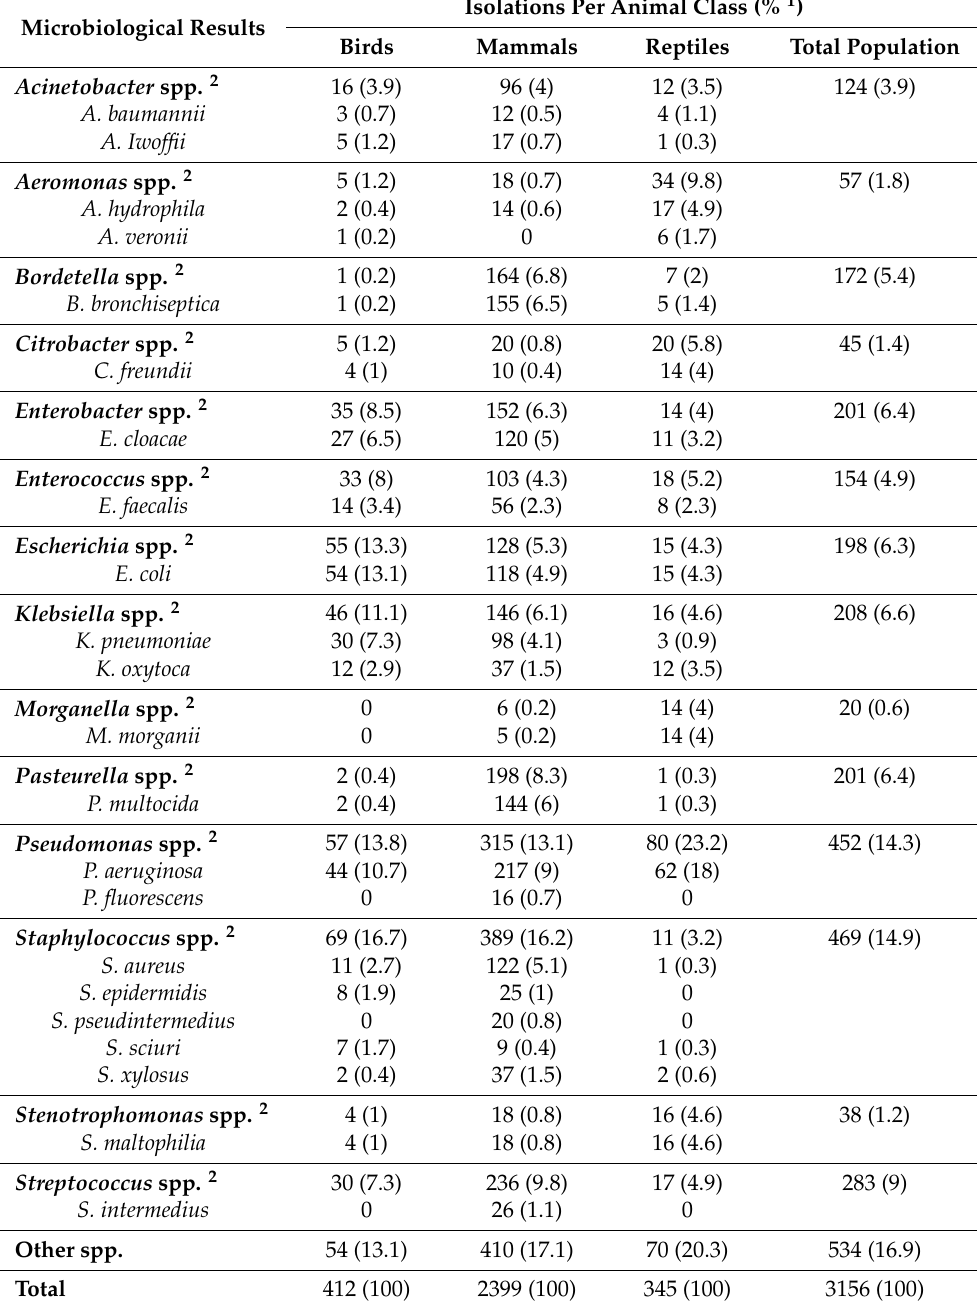
Table 3. Frequencies of bacterial species identified in each animal